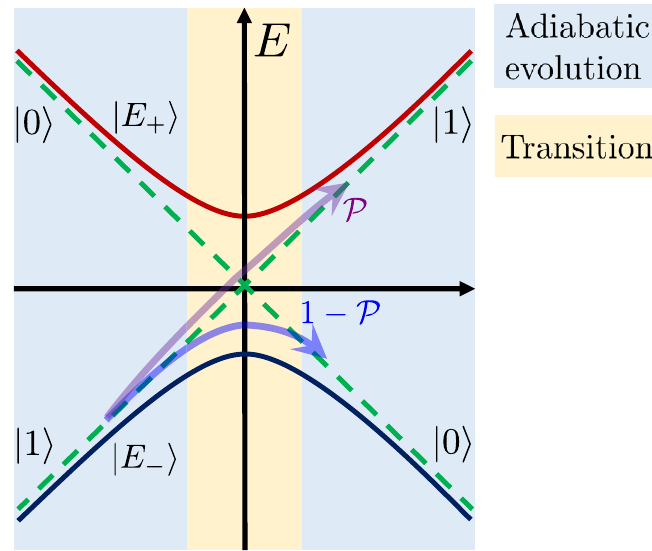
Figure 1. The two-level system and the adiabatic-impulse model. The approximation consists in the assumption that the evolution is described by the alternation of stages. During the adiabatic stages the system follows either a ground state E or an excited state E . The impulse-type transition (with the probability P ) is assumed to + − happen in the point of the minimal energy-level splitting. In this work, the adiabatic-impulse model is justified within Majorana’s